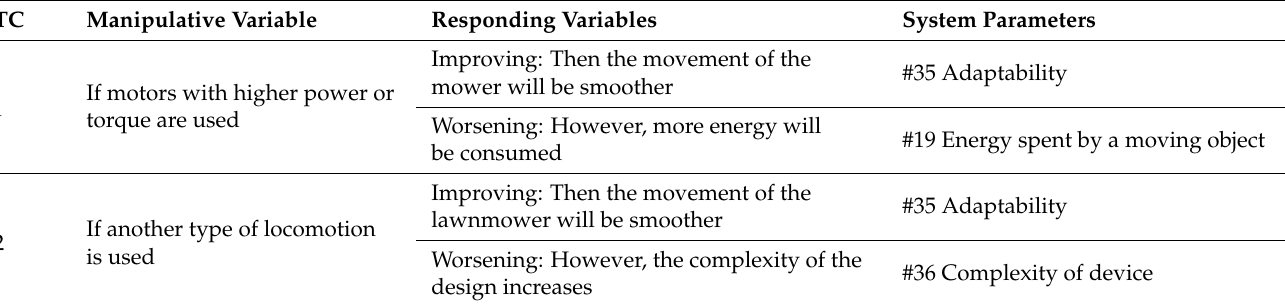
Table 2. System parameters for technical contradictions (constraint